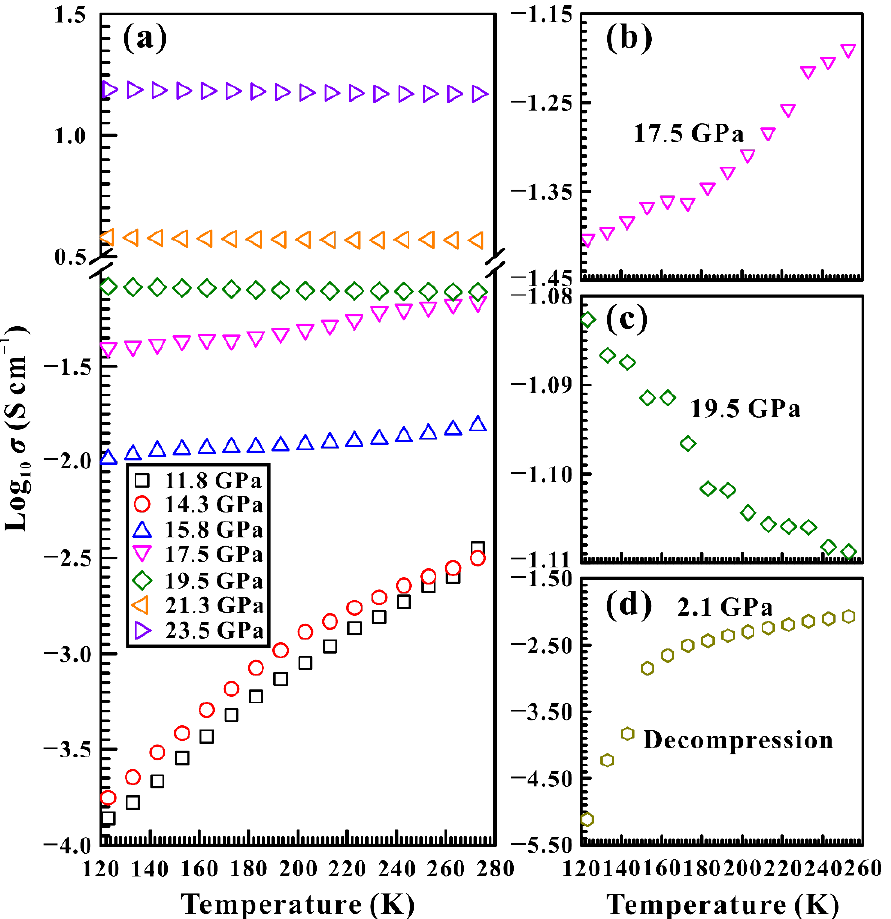
Figure 7. ( a ) The temperature—dependent logarithmic electrical conductivity for Ga 2 Se 3 at some representative pressure points of 11.8, 14.3, 15.8, 17.5, 19.5, 21.3, and 23.5 GPa; ( b )The semiconducting behavior of Ga 2 Se 3 at 17.5 GPa; ( c ) The metallic state of the sample at 19.5 GPa; ( d ) Typical semiconducting character for the recovered Ga 2 Se 3 sample decompressed to 2.1 GPa.